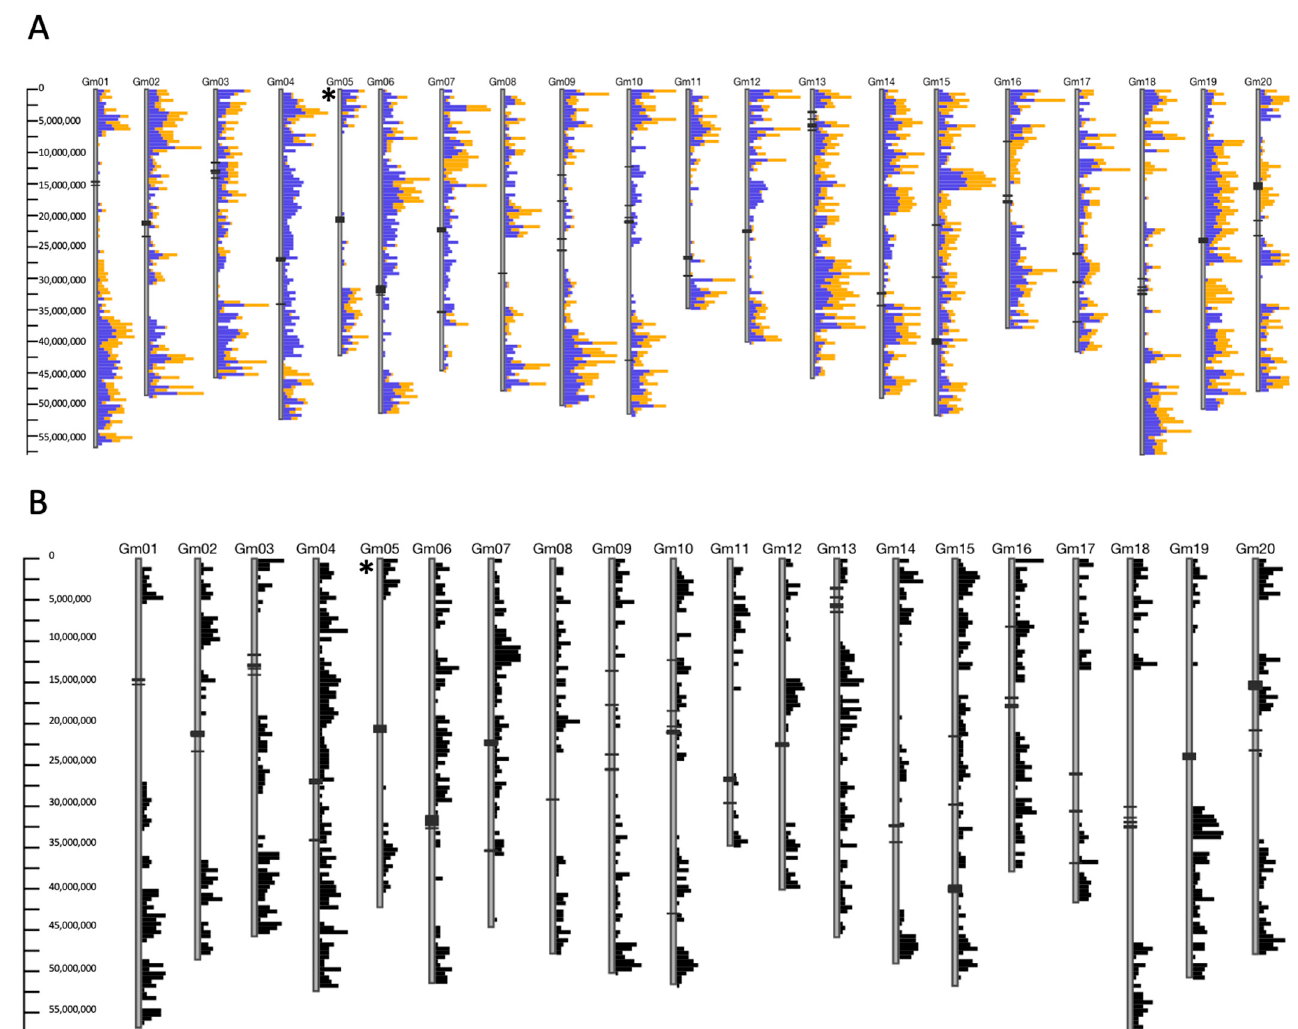
Figure 3. SNP profiles of Clark, Fiskeby III, and Mandarin (Ottawa). Each of the 20 chromosomes in soybean ( Glycine max ) is represented by a vertical line. SNP differences are represented by horizontal lines. Only SNPs that differ between the reference genotype and samples of interest are shown. The more SNP differences within a chromosomal region, the longer the line. The asterisk to the left of Gm05 indicates the location of the Gm05 iron efficiency QTL of interest [15] . ( A ). SNP differences between Clark and Fiskeby III (blue) and between Clark and Mandarin (Ottawa) (orange). ( B ). SNP differences between Fiskeby III and Mandarin (Ottawa).